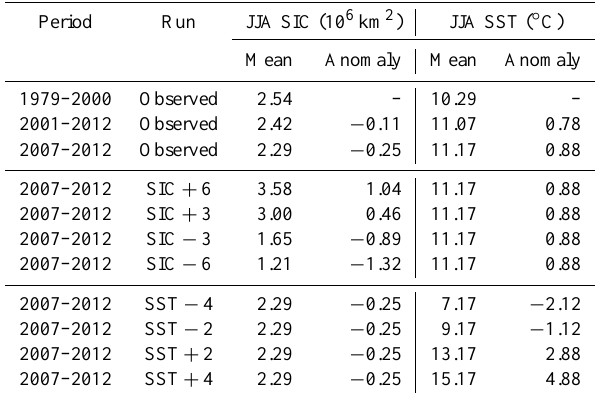
Table 1. Observed and applied JJA SIC and SST within MAR do- main. The SST is calculated for the assumed sea-ice-free ocean only (SIC ≤ 0 . 2) using the region within the black box displayed in Fig.